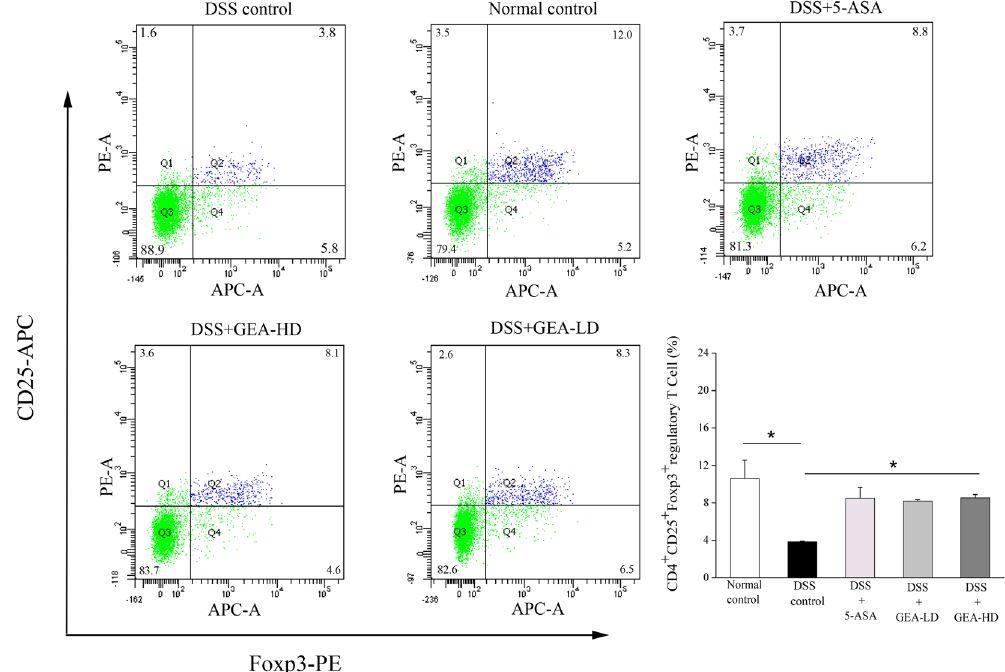
Figure 13. Turkish galls regulates the Treg cells in mice with DSS-induced UC. CD4 + T cells isolated from SPs of mice after treated with Turkish galls. The number of Treg cells were measured using flow cytometric assay. The values are expressed as the mean ± S.D. * P < 0.05, ** P < 0.01, *** P < 0.001.